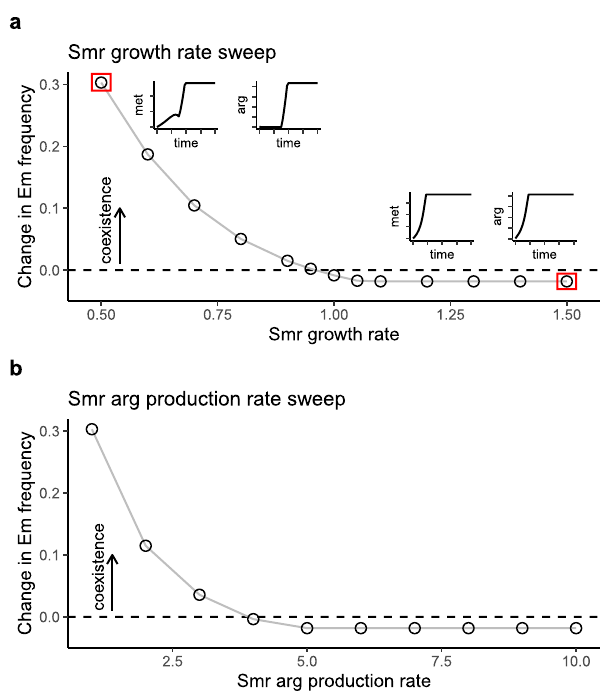
Fig. 4 Modeling shows that the shared mutualist ’ s growth rate and amino acid production rates affect coexistence. a Smr growth rate affects coexistence. Growth rates of Em and Er are set at their default levels ( µ Em = 1 and µ = 1.1) and coexistence is evaluated across a range of Smr Er growth rates. In these simulations, Em begins at a frequency of 0.1, and coexistence is indicated by an increase in frequency. Coexistence is possible when Smr ’ s growth rate is below 0.96. At the left-most point (red box), Em increases in frequency, and the inset plots show that methionine is unlimiting, while arginine is initially limiting. At the right-most point (red box), Em decreases in frequency and the inset plots show that neither methionine nor arginine is limiting at any time point. b The rate at which Smr produces arginine also determines coexistence. Em increases in frequency from an initial frequency of 0.1 when the arginine production rate is below 4, but decreases in frequency above this value, indicating that Er takes over the population. Amino acid dynamics at the far left and far right points are similar to the inset plots shown in part a . Source data are provided as a Source Data fi